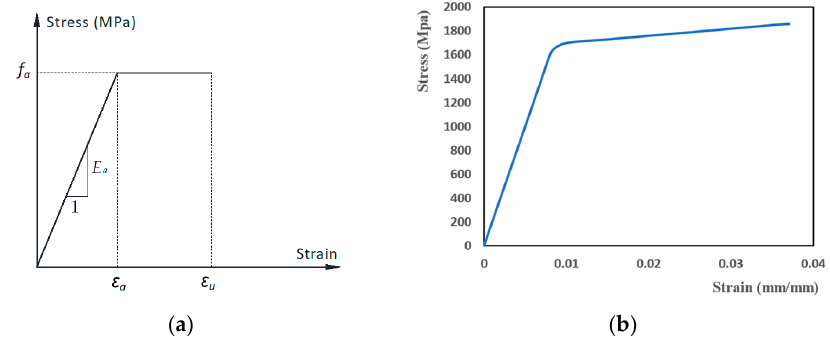
Figure 5. ( a ) Steel constitutive material model, ( b ) stress strain curve of cables.